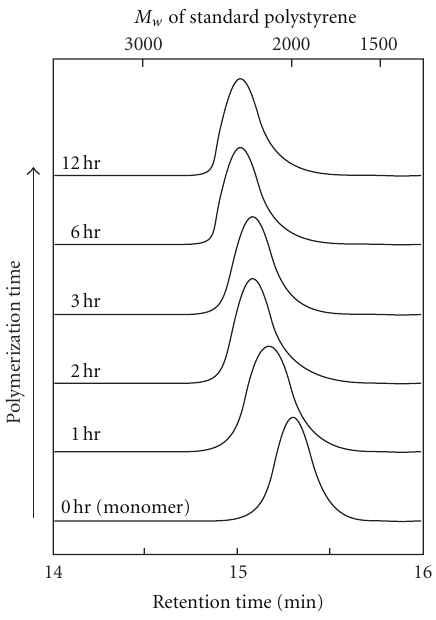
Figure 2: GPC curves of reaction solutions during polymerization of BS8T .